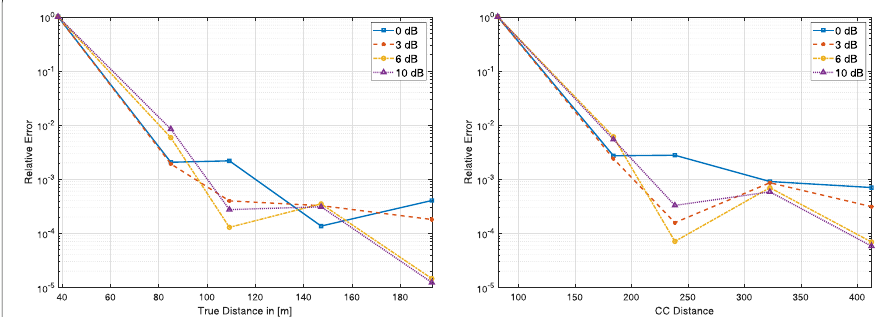
Fig. 11 Relative mean-square error of prediction δ 2 P and δ 2 C indicate that the LQP model provides reliable prediction of the outage probability of the , g out-of-sample